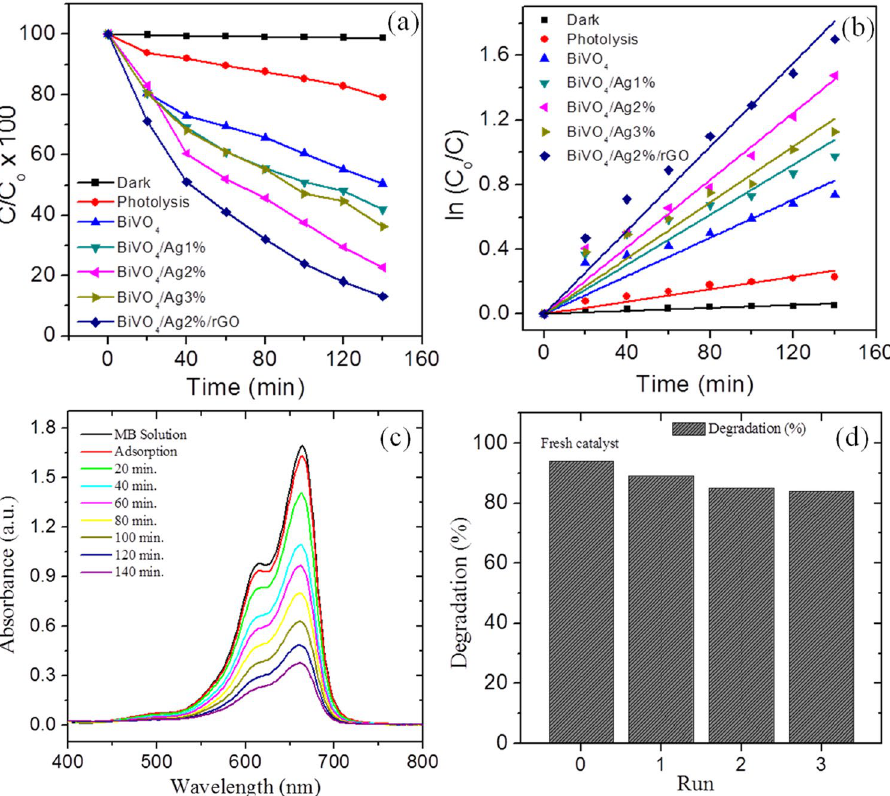
Figure 7. ( a ) Degradation of MB with time using different samples under visible light irradiation. ( b ) Chemical kinetic study of photocatalytic MB degradation over various samples. ( c ) UV-Vis absorption spectra of the MB dye solution during photocatalysis at successive time intervals in the presence of the recycled BiVO 4 /Ag2%/rGO photocatalyst sample. ( d ) Bar diagram of the recycled runs showing the MB dye degradation efficiency over the BiVO 4 /Ag2%/rGO